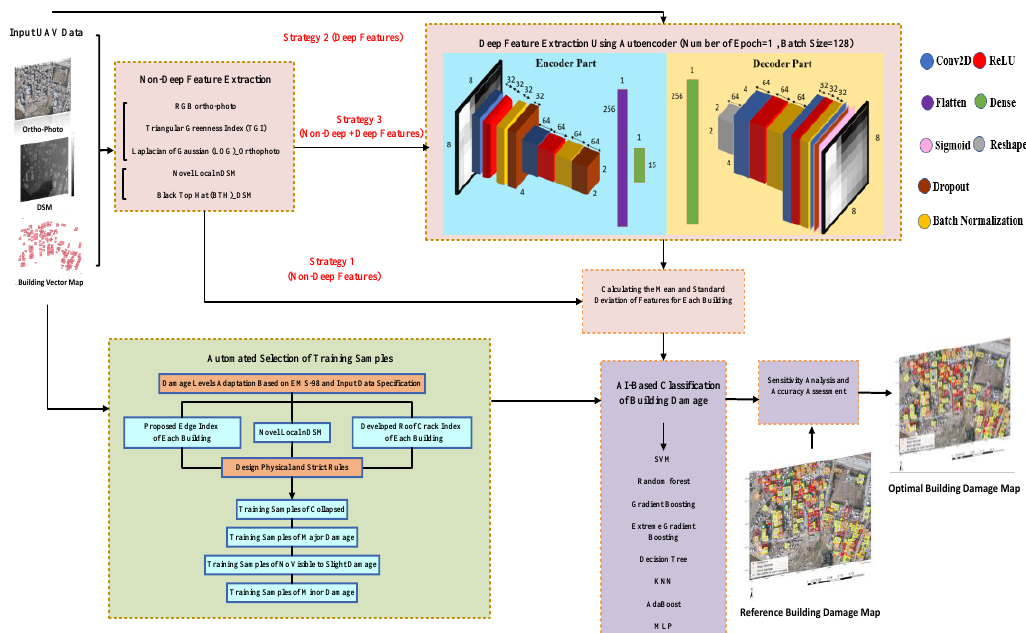
Figure 2. The general framework proposed for producing the damage map of buildings. In the first step, three different feature-extraction strategies are carried out to inves- tigate their suitability for optimal detection of damage levels. These strategies embrace extracting (1) non-deep features (NDF), (2) deep features (DF), and (3) fused deep and non-deep features (FF). In the first strategy, in addition to the RGB bands of the orthophoto, triangular greenness index (TGI) and Laplacian of Gaussian (LOG) are calculated from those bands. Moreover, a novel local nDSM and black top hat (BTH) are calculated from input DSM data. In strategy 2, a one-epoch convolutional autoencoder (OECAE) is designed to extract deep features from a stacked form of the orthophoto and DSM. In the last feature-extraction strategy, non-deep features are fed to the OECAE to achieve fused deep and non-deep features. Subsequently, mean and standard deviation (SD) of the extracted features for each feature-extraction strategy are calculated and fed to the classification step as the final features. In the second step, a fully automatic procedure based on physical and strict rules is proposed to select training samples of all the building damage levels. In this step, a novel roof crack index and edge index are presented to facilitate de- signing of efficient rules for selection of the training samples. Following that, in order to achieve damage mapping, some AI-based classifiers — including seven machine learning methods and a basic deep learning method — are implemented in the final step. Utilizing each of the three mentioned feature-extraction strategies in each of the eight classifiers resulted in a total of 24 damage maps. Eventually, the final map is made by conducting a given in the following sections.